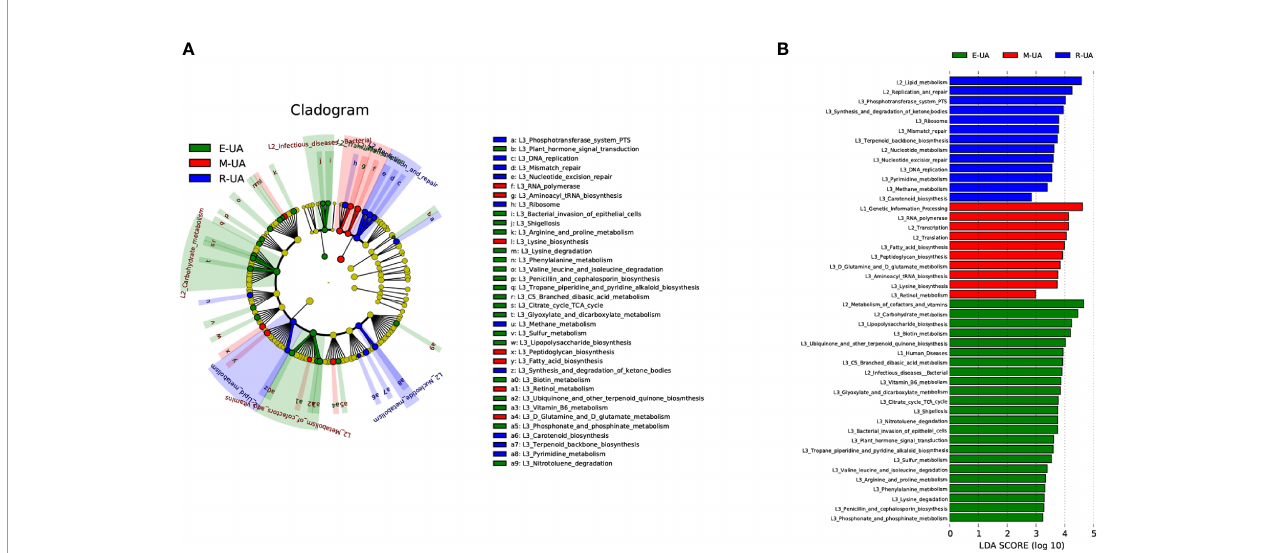
FIGURE 5 | Microbiota-associated functional changes in the three groups. Distribution (A) and comparison (B) of Kyoto Encyclopedia of Genes and Genomes (KEGG) metabolic pathways among the three groups were shown at the taxonomic level using LEfSe analysis. LEfSe, linear discriminant analysis (LDA) effect